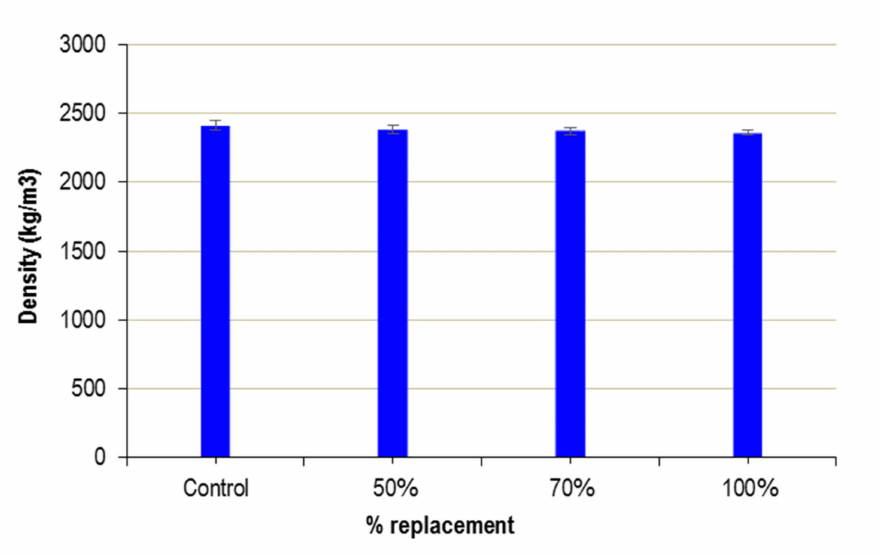
Figure 5. Density of UHPFRC.